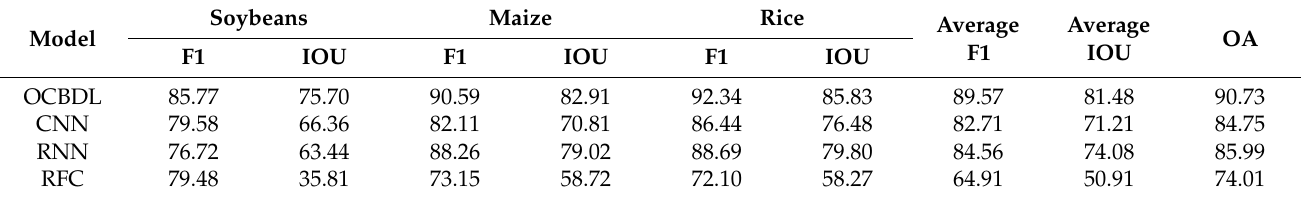
Table 2. The classification accuracy of crop classification using the different methods.